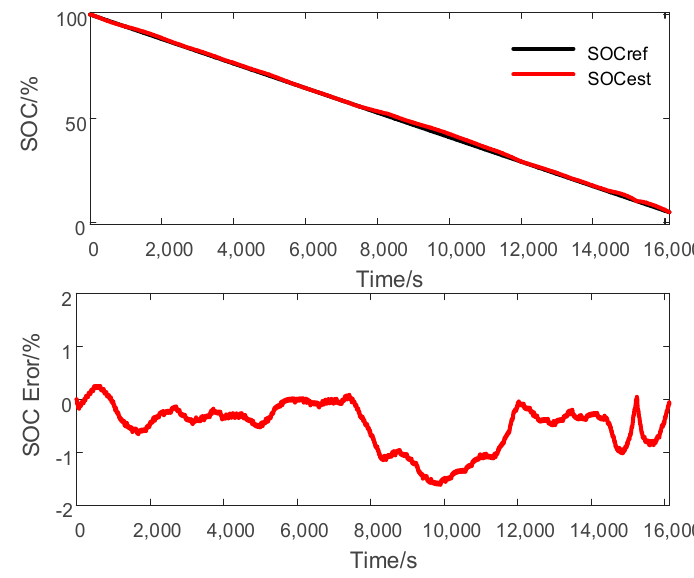
Figure 10. Conventional sliding mode observer (CSMO)-based SOC estimation.